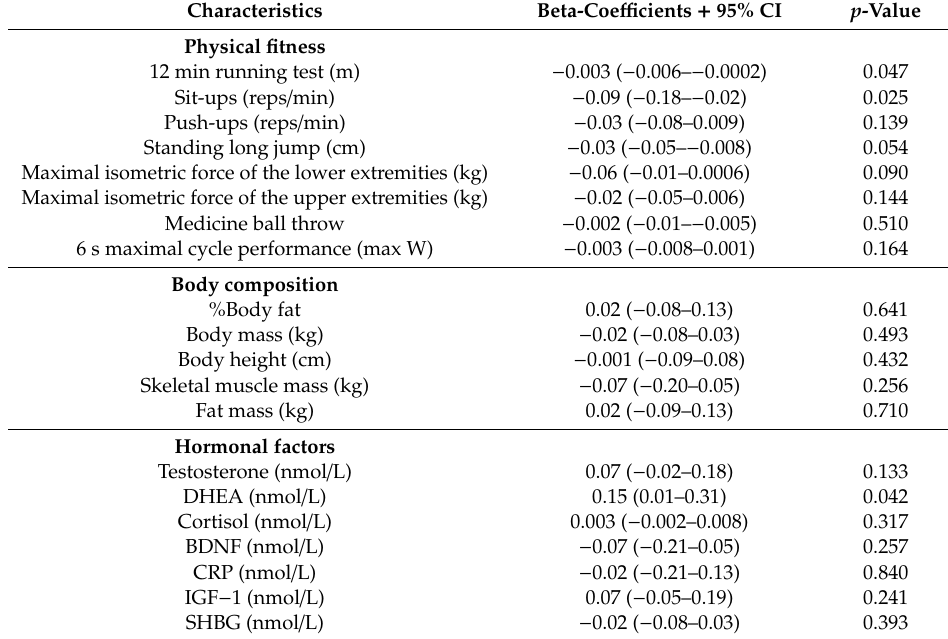
Table 2. The associations (logistic regressions) of baseline physical fitness, body composition, hormonal and psychological factors with drop-out from the survival